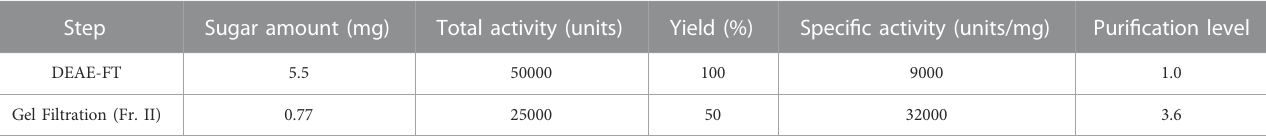
TABLE 3 Puri fi cation